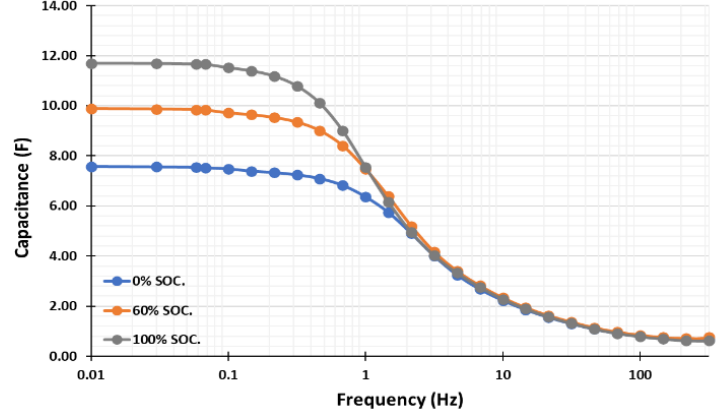
Figure 4. Capacitance variation depending on the frequency at each SOC.